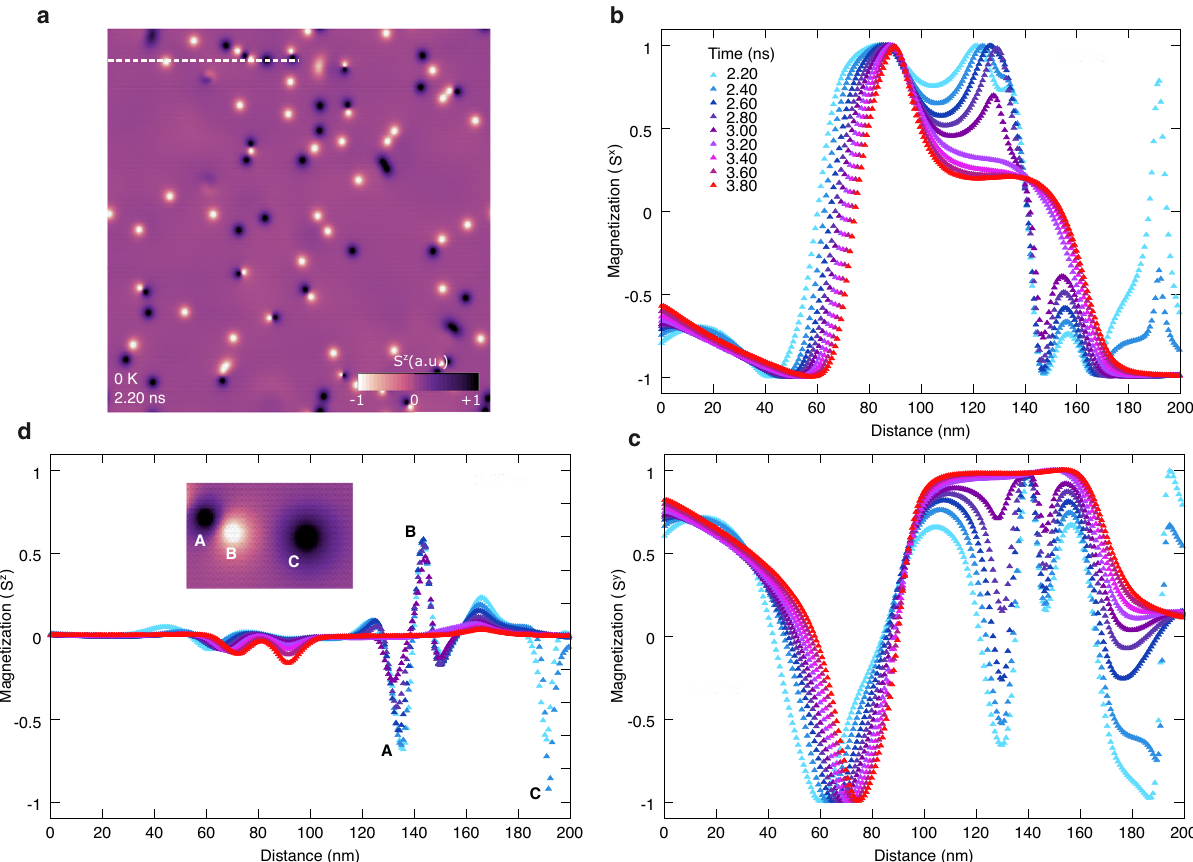
Fig. 5 Spin fl uctuations-driven magnetic domain metastability. a Snapshot of a spin dynamics of monolayer CrCl 3 obtained through zero- fi eld cooling after 2 ns and reaching 0 K. The magnetization perpendicular to the surface ( S z ) is displayed showing the formation of merons and antimerons (small dots). Bright (dark) areas correspond to S z = ±1, respectively, in the color scale. A path (dashed line) of 200 nm is drawn to show the spatial variation of the magnetization at different times ( t ≥ 2.20 ns). b – d Variations of the in-plane components of the magnetization ( S x , S y ) and S z , respectively, along of the path shown in a within 2.20 – 3.80 ns after 0 K is reached. The inset in d shows a small area from a along the path with the formation of the merons and antimerons. The corresponding variation of S z at different times at A, B, and C is also